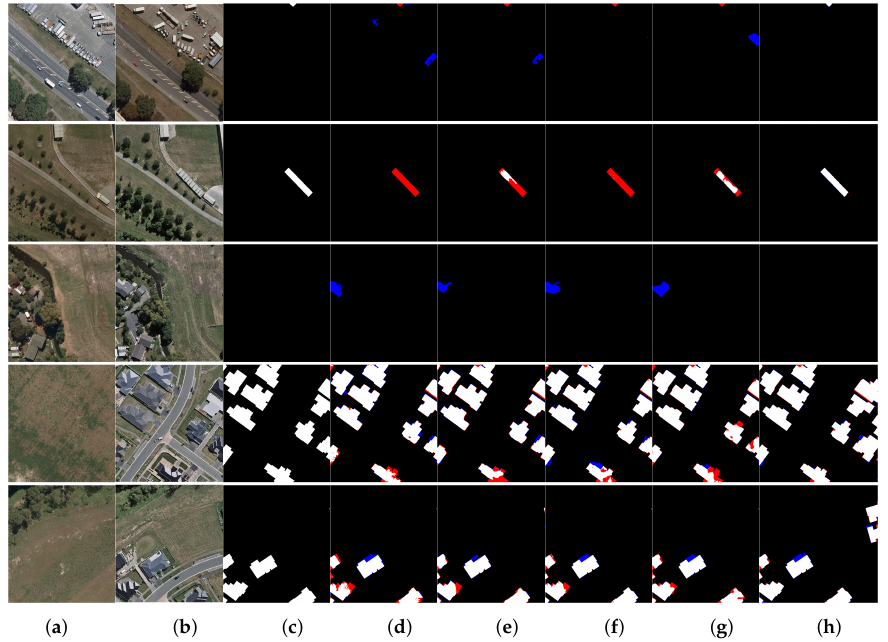
Figure 12. Inference results on the WHU dataset. ( a ) Pre-temporal images. ( b ) Post-temporal images. ( c ) Ground truths. ( d ) Inferences of FC-Sima-diff. ( e ) Inferences of IFN. ( f ) Inferences of SNUNet_CD. ( g ) Inferences of BiT. ( h ) Inferences of RFNet. We visualize the missing changes with red and unexpected changes with